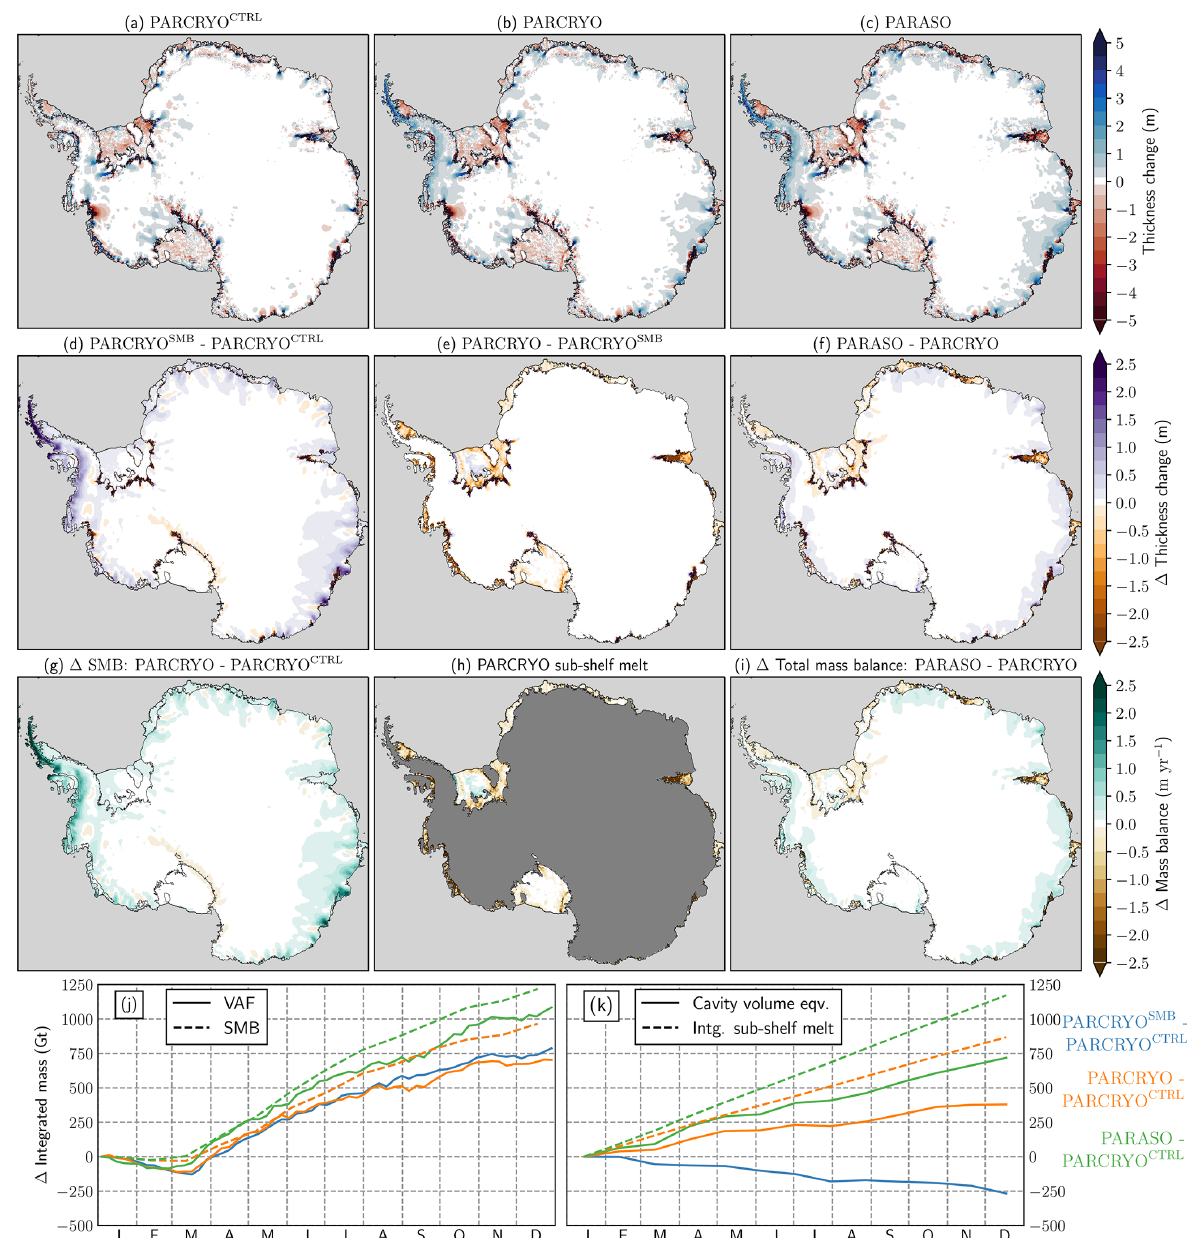
Figure 7. (a–c) Ice-thickness change during the year 2001 for (a) PARCRYO CTRL , (b) PARCRYO and (c) PARASO. (d–f) Difference of the ice-thickness change between (d) PARCRYO SMB and PARCRYO CTRL , (e) PARCRYO and PARCRYO SMB and (f) PARASO and PARCRYO. (g) Difference between the mean SMB applied for PARCRYO (SMB based on PARATMO) and for PARCRYO CTRL (SMB from initialization run based on AEROCLOUD). (h) Mean subshelf melt rates (from PAROCE) applied for PARCRYO (equivalent to (cid:49) (PARCRYO–PARCRYO CTRL ) since no subshelf melt is applied in PARCRYO CTRL ). Out of consistency with panel (g) , negative (positive) values indicate melting (refreezing). (i) Difference of the total mass balance between the coupled PARASO and the stand-alone PARCRYO experiment. (j) Change of the volume above floatation (VAF) and the integrated SMB and (k) change of the cavity volume and the integrated subshelf melt. (j–k) PARCRYO SMB , PARCRYO and PARASO are plotted as anomalies compared to PARCRYO CTRL . In panel (j) , the PARCRYO SMB SMB anomalies are not plotted as they are identical with that of PARCRYO, by design. In panel (k) , the PARCRYO SMB integrated subshelf melt anomalies are not plotted as no melt is applied for that experiment. All results are from 2001 (second simulated